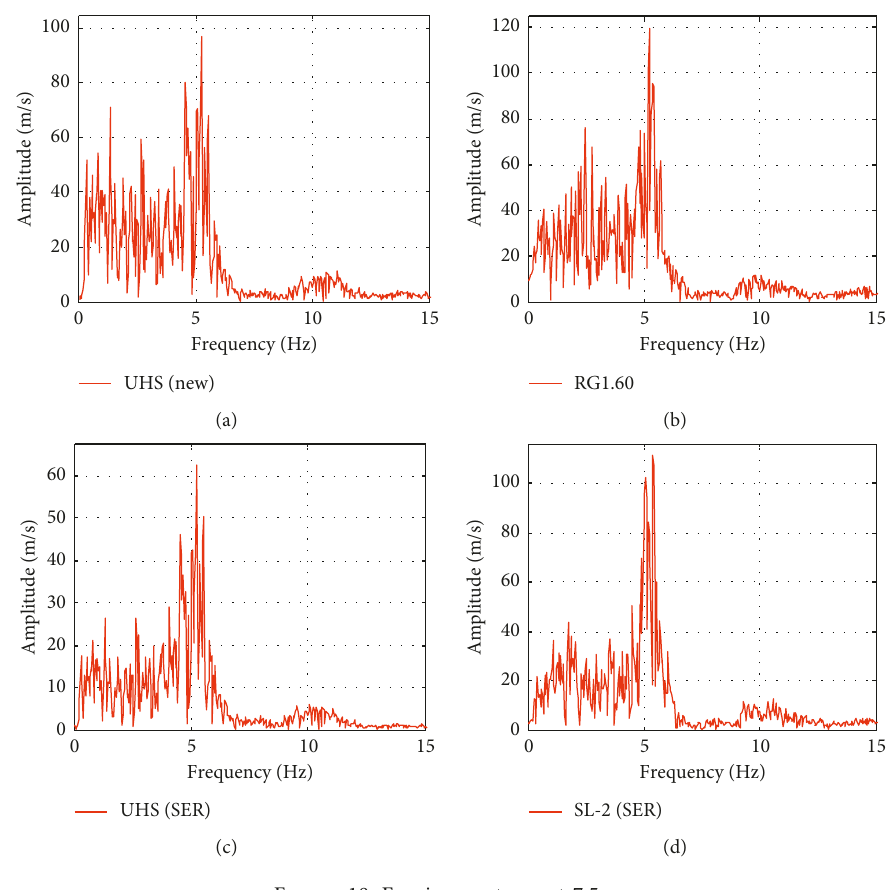
Figure 18: Fourier spectrum at